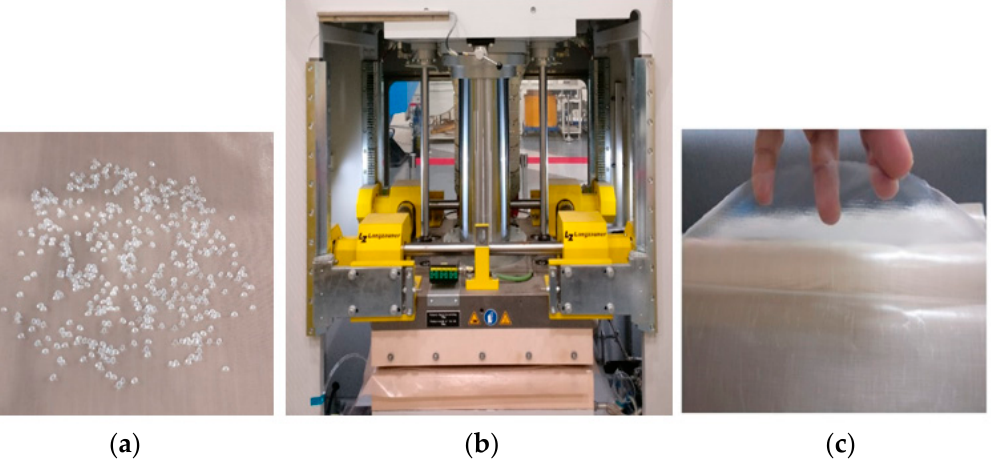
Figure 2. ( a ) Thermoplastic pellets; ( b ) Pellets being compressed in a hot press; ( c ) Fabricated thermoplastic film.